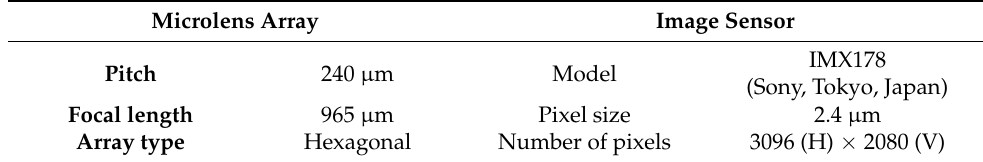
Figure 3. ( a ) Schematic of optical alignment module for VF-LFC. ( b ) Photographs of the assembled module for VF-LFC ( c ) Photographs of light field image captured by VF-LFC with focal length FL 20 mm (left), and FL 75 mm (right), inset: original texture image. Table 1. Parameters of MLA and image